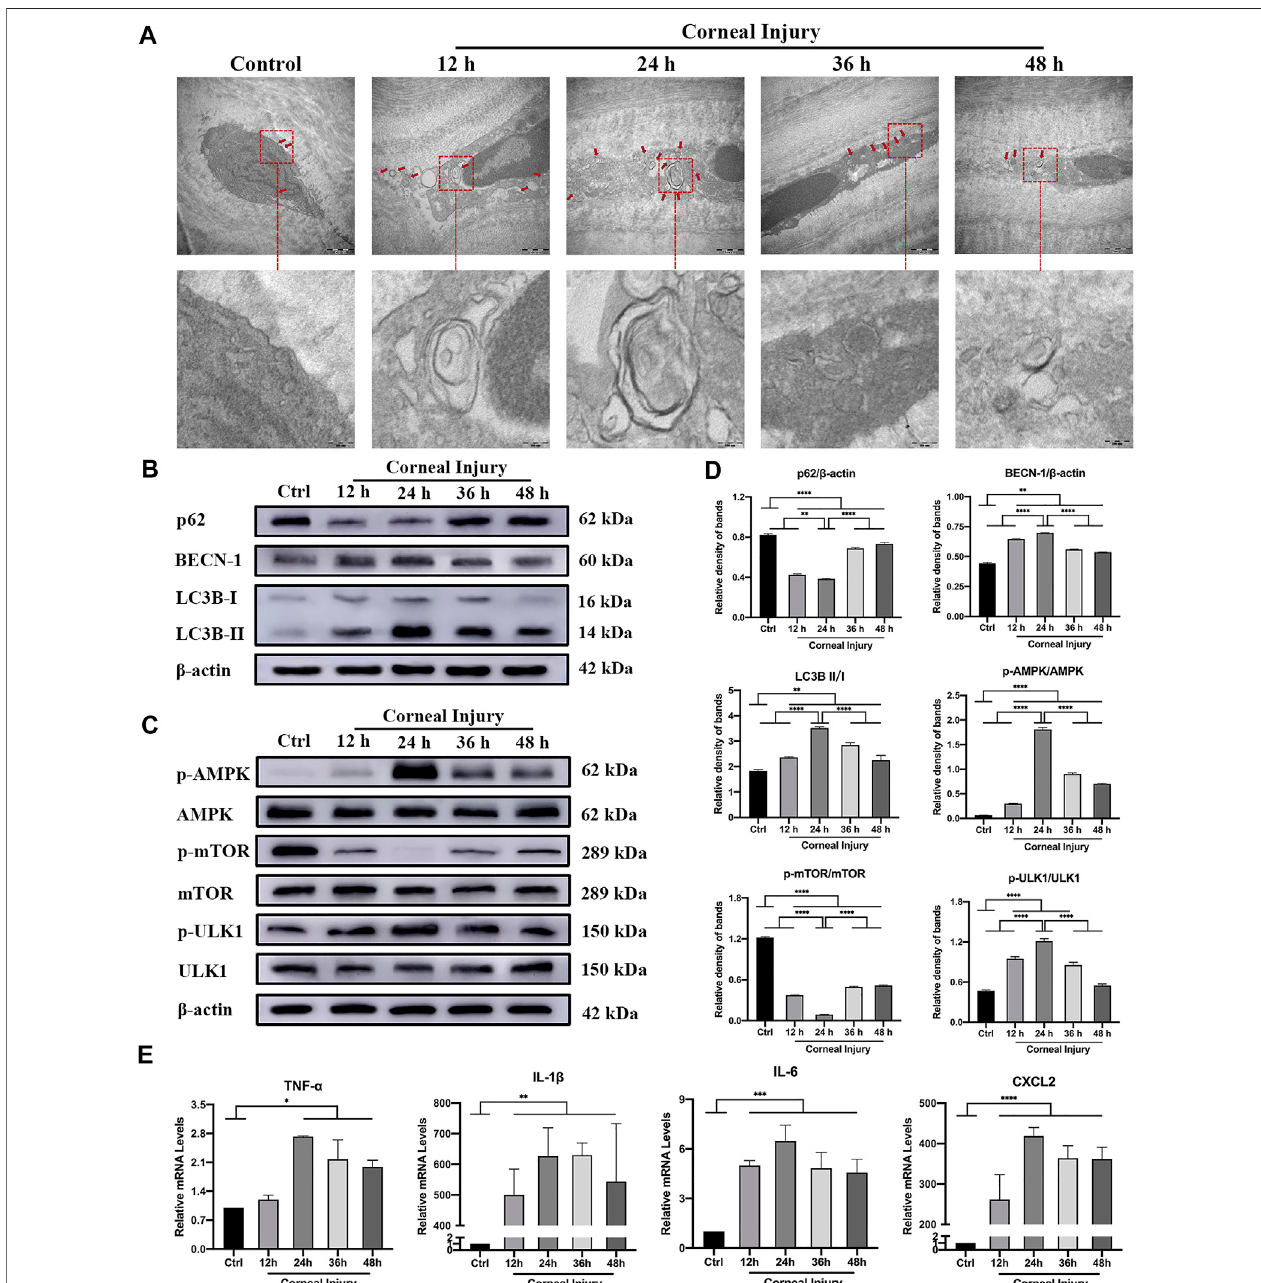
FIGURE 4 | Autophagy and in fl ammation in the corneas of corneal injury (CI) mice. (A) Representative high magni fi cation TEM pictures showing autophagosomes with double membrane structure were formed in CI models. Scale bar: 500 and 100 nm. (B) Western blotting showing expressions of the autophagy marker proteins p62, Beclin-1, and LC3B. (C) Western blotting showing the expression of the AMPK-mTOR-ULK1 autophagy fl ux pathway proteins pAMPK, AMPK, pULK1, ULK1, pmTOR and mTOR. (D) Relative band densities of p62, Beclin-1, LC3BII/I, and the ratios of pAMPK/AMPK, pULK1/ULK1, and pmTOR/mTOR. (E) Quantitative PCR results for mRNA levels of the in fl ammatory cytokines TNF- α , IL-1 β , IL-6, and CXCL-2. Data are shown as mean ± SD. *p < 0.05, **p < 0.01, ***p < 0.001, ****p < 0.0001.